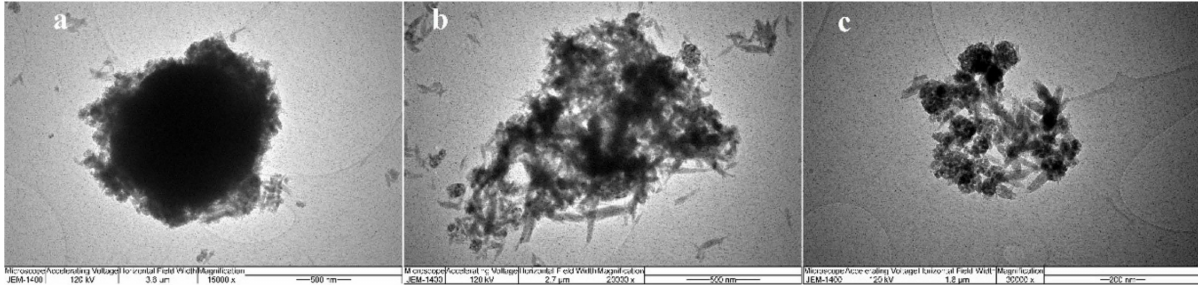
Figure 5. TEM images of ( a ) TiO 2 /HAp-01, ( b ) TiO 2 /HAp-02, and ( c ) TiO 2